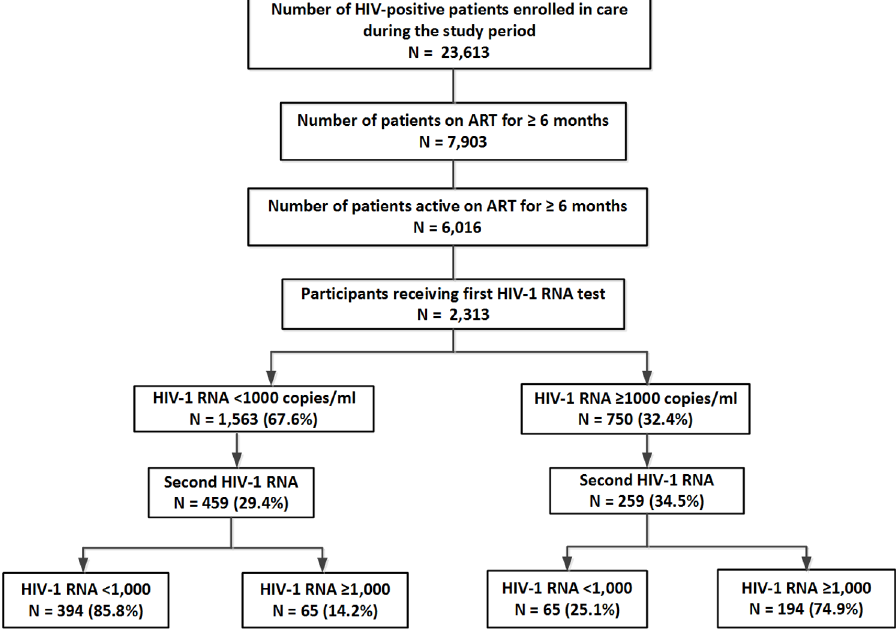
Fig 1. Flowchart describing the number of patients with first and second VL test and percent of virologic suppression among